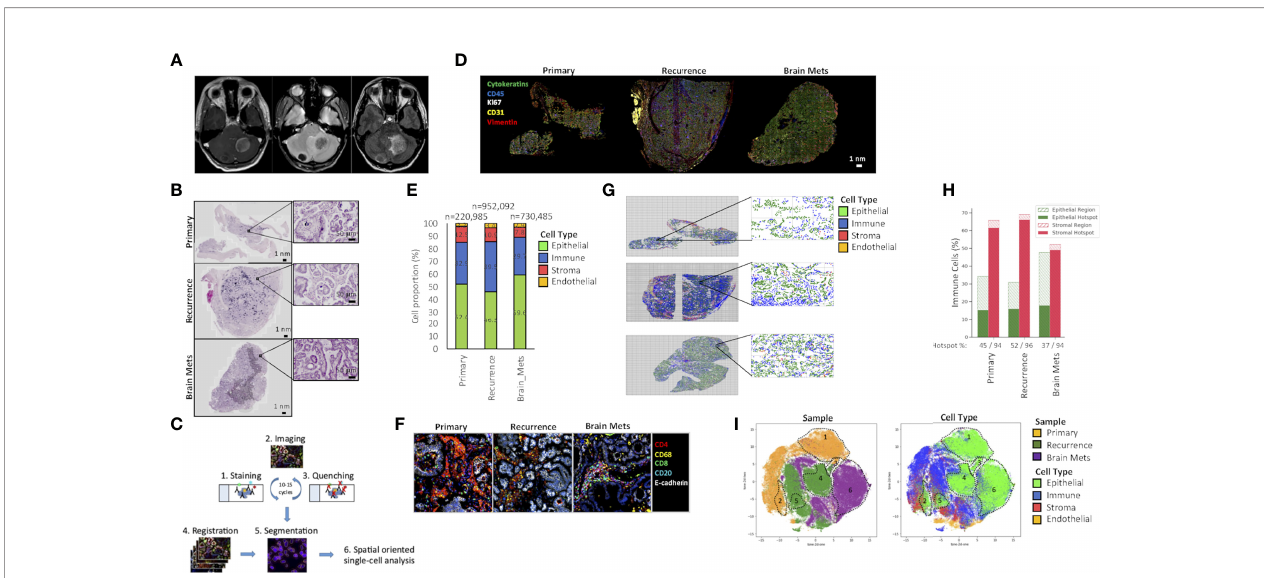
FIGURE 1 | Tumor architecture and composition. (A) Brain mets magnetic resonance imaging (MRI). Axial T1 post contrast (left panel) showing two peripherally enhancing masses in the cerebellum. Axial T2* (center panel) demonstrates hypointensity within these masses, indicative of mineralization, and con fi rmed by hyperdensity on MRI. Axial FLAIR (right panel) with mild hyperintense edema surrounding these masses, particularly the large left cerebellar mass, with mild mass effect on the fourth ventricle. (B) H&E staining of the primary ovarian tumor, a pelvic recurrence, and brain mets. (C) Cyc-IF framework. For each sample, sequential cycles of staining, imaging, and quenching are performed on a single tissue slide. The images are then aligned through registration, and the segmentation is performed. After extracting the mean intensities of each marker in each cell, a spatially oriented single-cell analysis is performed. (D) Immunostaining of epithelial (E-cadherin, cytokeratins), endothelial (CD31), stromal (vimentin), and proliferative (Ki67) markers of the primary ovarian tumor, a pelvic recurrence, and brain mets. (E) Tumor composition. The Cyc-IF analysis allows the classi fi cation of all cells within epithelial, immune, stromal, and endothelial compartments. The histogram represents the percentage of epithelial, immune, stromal, and endothelial cells in each tumor sample. (F) Example of a region enriched in immune cells with the presence of immune “ hot spots ” . (G) Grid analysis. Each tissue analyzed by Cyc-IF was reconstructed using the x and y coordinates of the nucleus. A grid was used to analyze the proportion of each cell type in discrete regions of the tumors. (H) For each tumor, the immune cell distribution within the epithelial and stromal compartments was calculated based on the grid analysis. Cells found in aggregates were considered as part of an immune “ hot spot ” . (I) UMAP analysis performed on a subset of 200,000 cells randomly selected across each tumor. Colors represent the samples and the cell type. The full name of each protein can be found in Supplementary Table S1